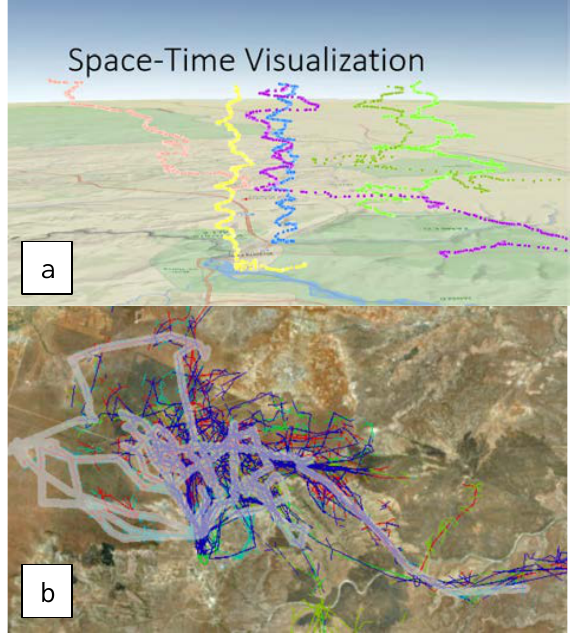
Figure 8. Animated 3D visualizations of color-coded individual bull elephant movements (a) and corridor analysis (b) provide information on the spatio-temporal patterns of elephant behaviour over